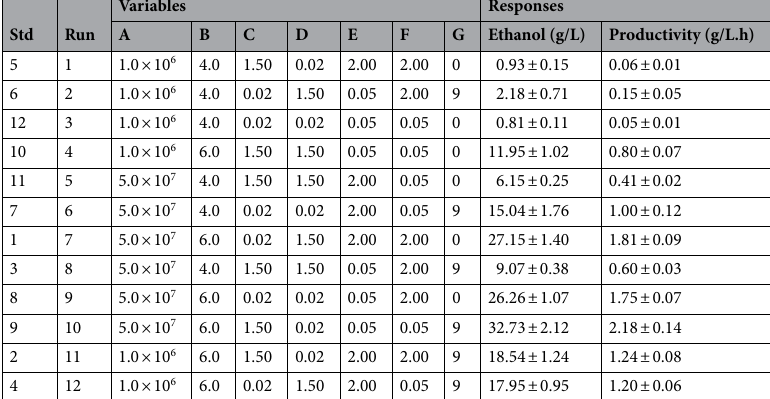
Source Sum of square